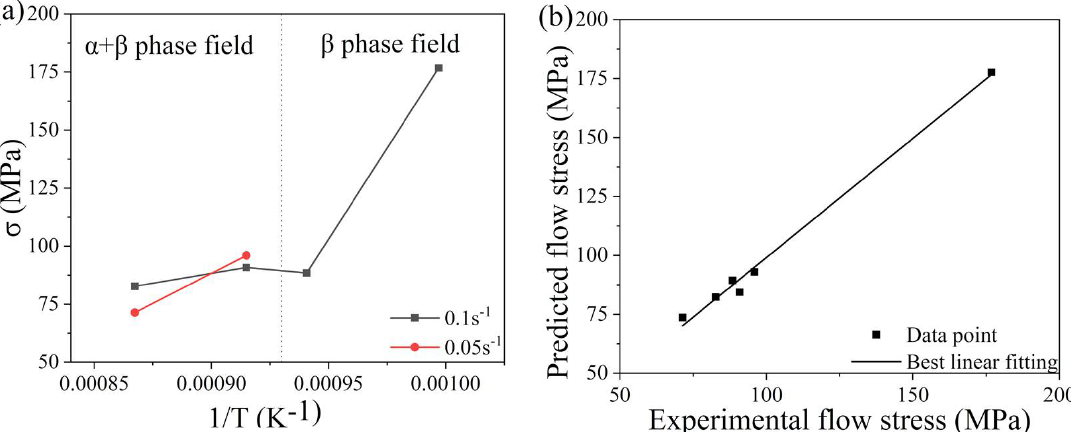
Figure 4. ( a ) The relationship between the flow stress ( σ ) and deformation temperature ( T −1 ). ( b ) Fitting relationship between the experimental flow stress and predicted flow stress, when the strain is 0.1.